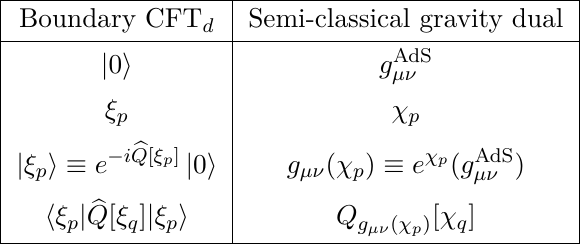
Table 1 . Summary of our proposal for the holographic description of the boundary states (1.4), that correspond to | ξ p i on the first column with p = T, R, D respectively. The boundary charge b Q in the first column are written in (1.3), where we add a hat to remind ourselves it is an operator. The metric g µν ( χ p ) in the second column is obtained by acting on the pure AdS d +1 metric with the (finite) transformation generated by χ p . Q [ χ q ] corresponds to the Noether charge associated g µν ( χ p ) to the vector χ q computed in the metric g µν ( χ p )